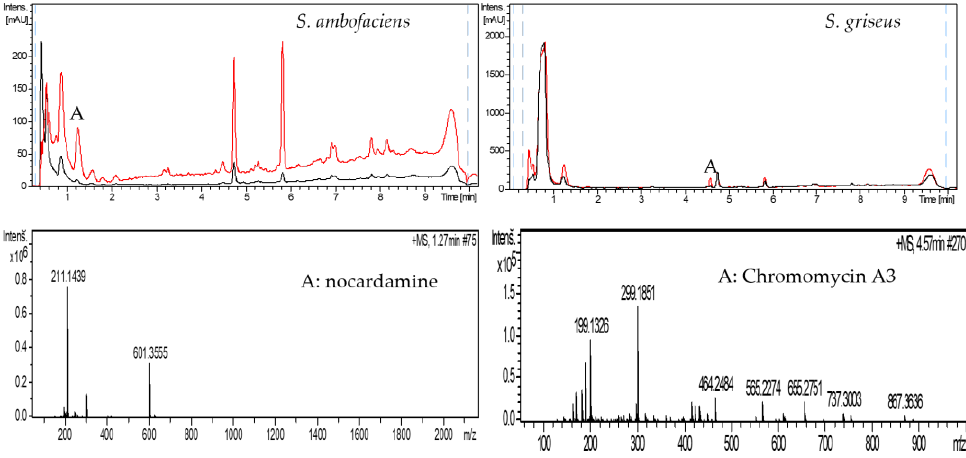
A. S. olivaceus produced six differential peaks in the chromatogram (Figure 4 right — peaks